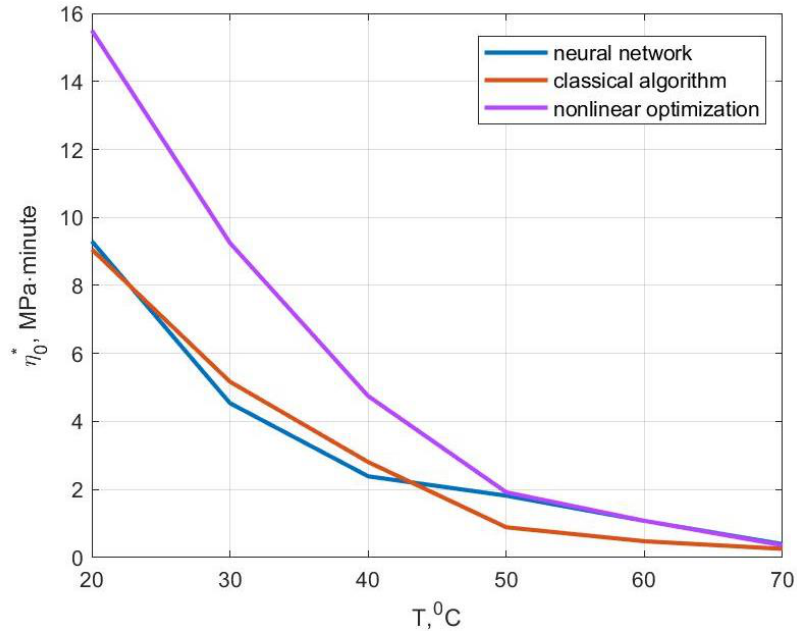
Figure 13. Comparison of the initial relaxation viscosity values obtained by different methods.